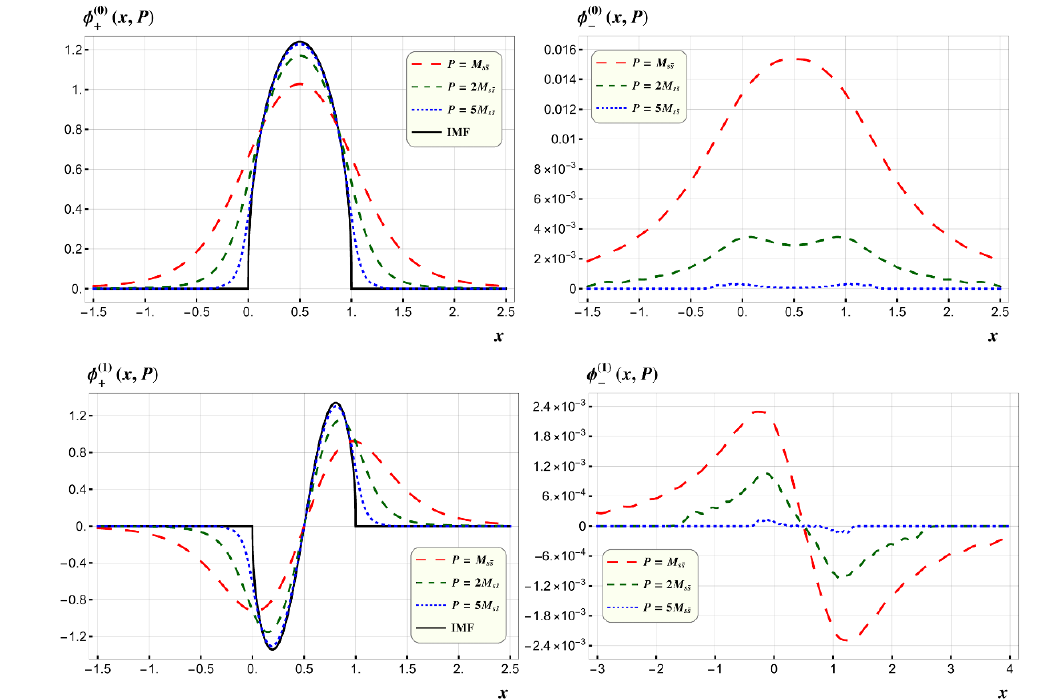
Figure 10 . Bars-Green wave functions for the low-lying strangeonium family with m s = 0 : 749: ground state ((cid:12)rst row), and the (cid:12)rst excited state (second row).